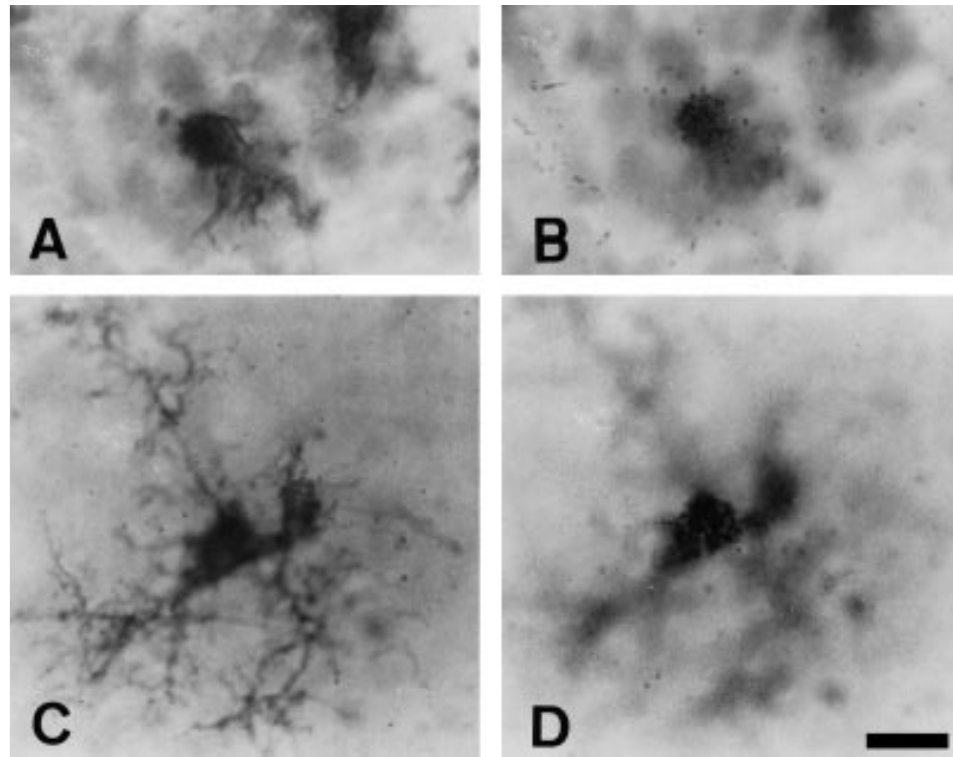
Figure 5 - Proliferation of ame- boid and ramified microglia. High power photomicrographs of coronal sections passing through the midbrain tectum of pouch young opossums that received a single intraperitoneal [ 3 H]-T in- jection (10 µCi/g body weight) at P24 (A and B) or P59 (C and D) and were killed 2 h later. Sec- tions were incubated with an HRP conjugate of the BS1/B4 Griffonia simplicifolia isolectin (Sigma). A and C, Focus on the histochemical reaction; B and D, focus on the radioautographic emulsion (C and D modified from Ref. 22; courtesy of SBPC). Mag- nification bar = 10